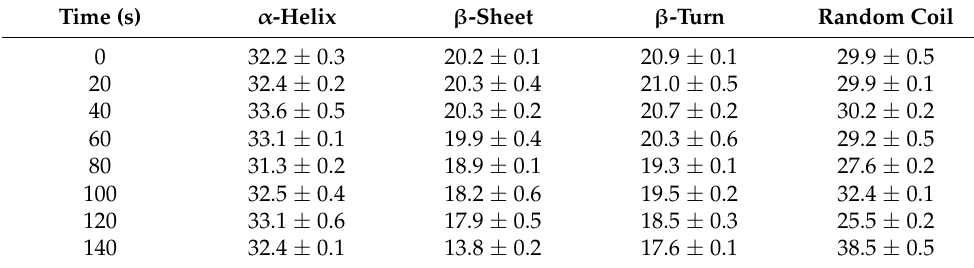
Figure 3. Spectroscopy curves of the PME solution after RF heating treatment. ( a ) Curve of CD spectroscopy and ( b ) curve of fluorescence spectroscopy. The electrode gap of the RF system was set as 90 nm. RF heating time was 0 s, 20 s, 40 s, 60 s, 80 s, 100 s, 120 s, and 140 s. Table 1. Composition of the secondary structures of PME